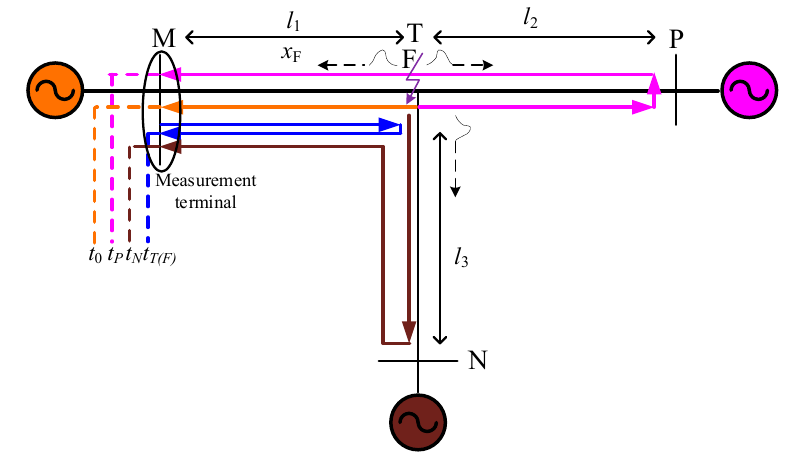
Figure 7. Travelling wave propagation path in connection point T.